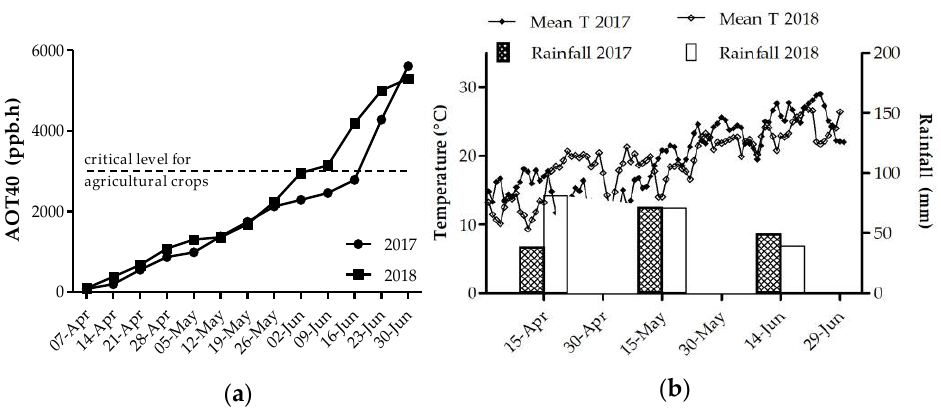
Figure 3. ( a ) Accumulated dose over a threshold of 40 ppb (AOT40) of ozone and threshold of 3000 ppb.h (critical level for crop species not to be exceeded in three months); ( b ) rainfall distribution during the two years of the survey (April–June, each year) and mean daily temperature (Mean T).